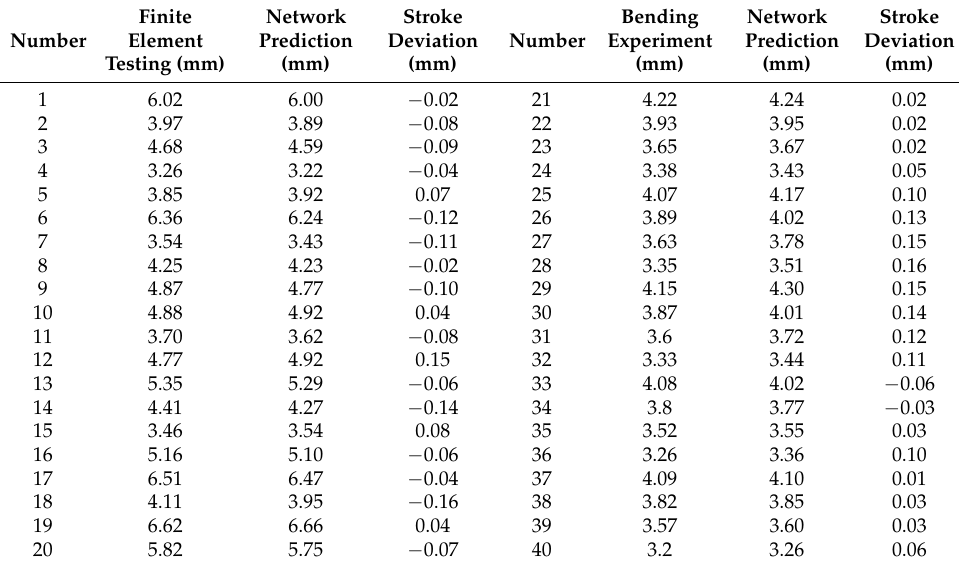
Table 6. Comparison between testing samples and model